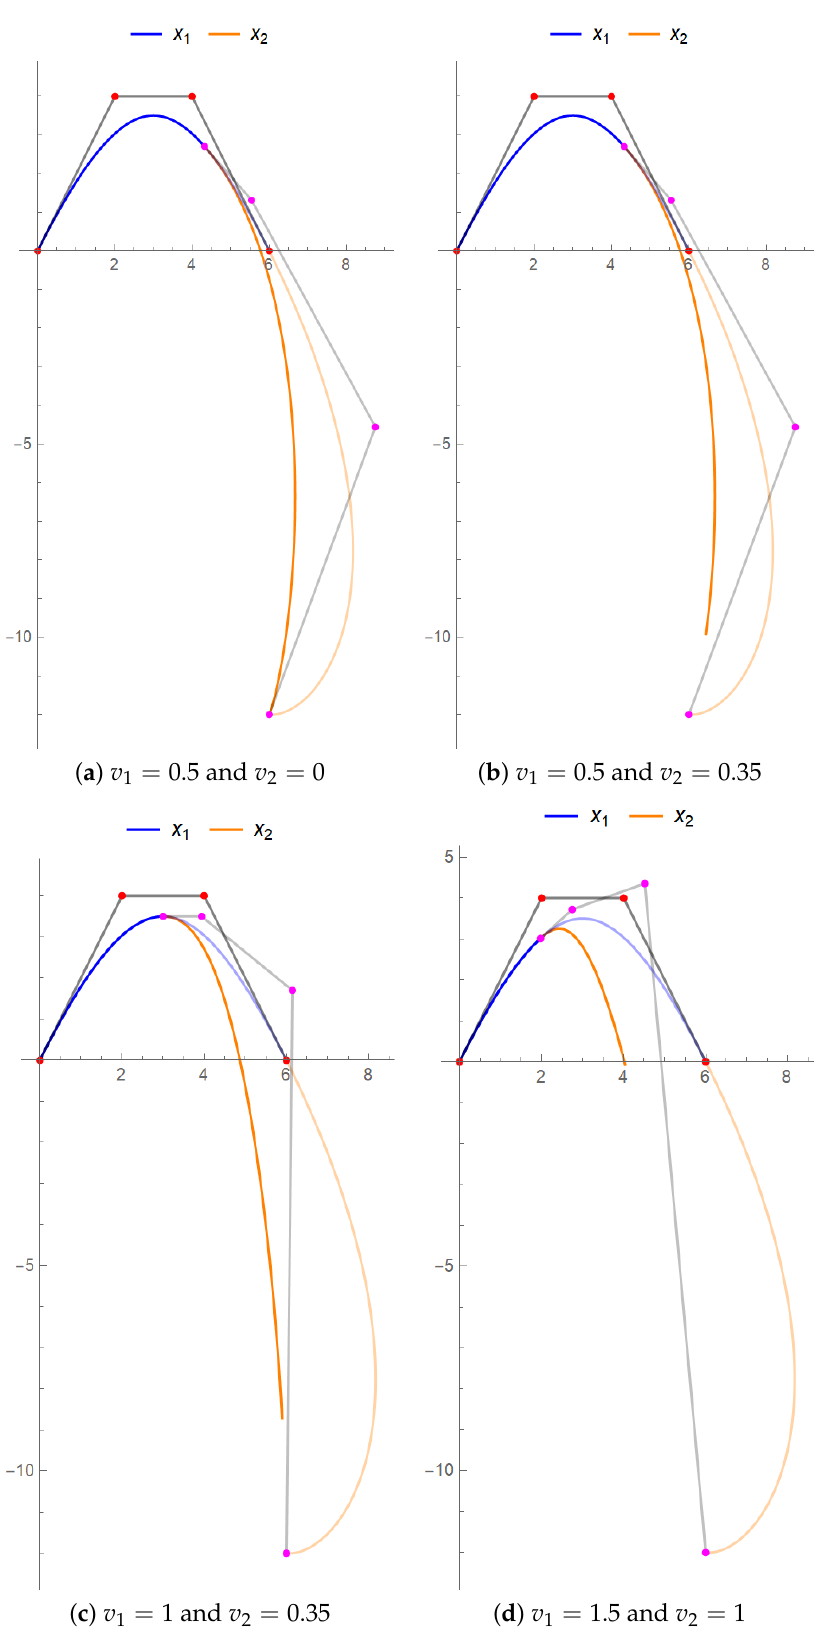
Figure 15. F 2 continuity with multiple values of v 1 and v 2